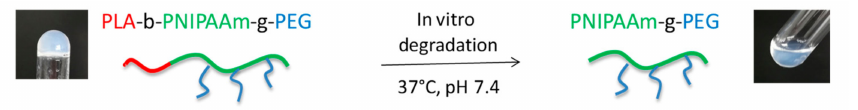
Figure 1. Description of the approach based on PLA-b-PNIPAAm-g-PEG, with PLA as a “sacrificial” block. PLA: polylactide, PNIPAAm: poly(N-isopropylacrylamide, PEG: polyethylene